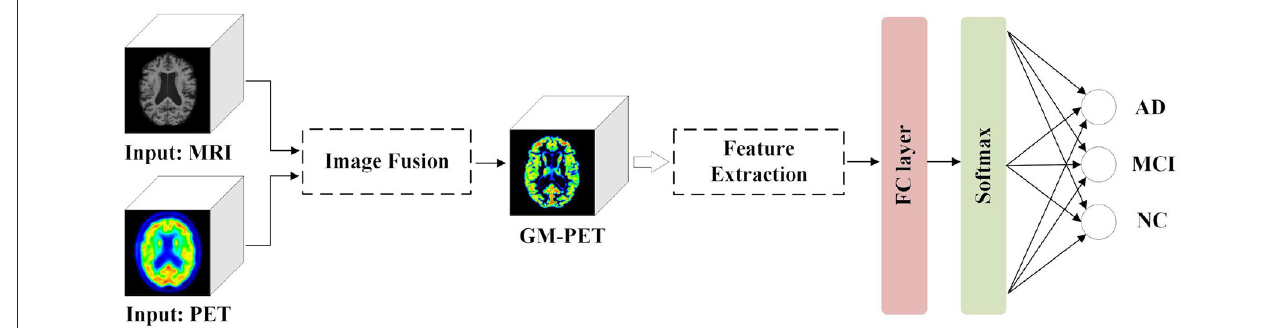
FIGURE 1 | Proposed AD diagnostic framework with multimodal image fusion method.